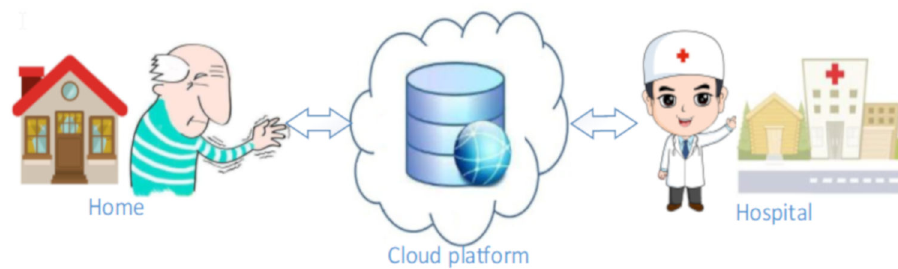
Figure 1. Framework of cloud rehabilitation system for upper